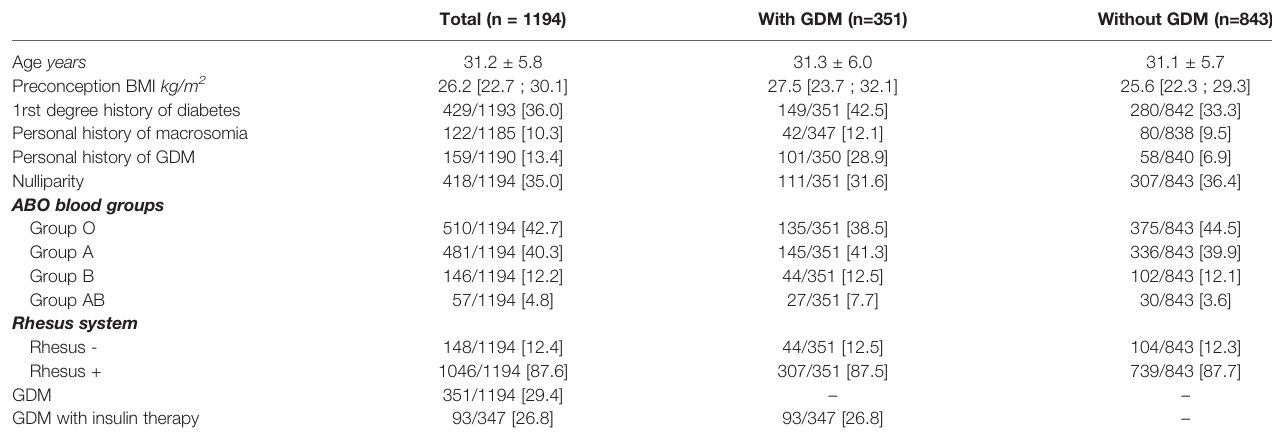
TABLE 1 | Baseline characteristics of the study